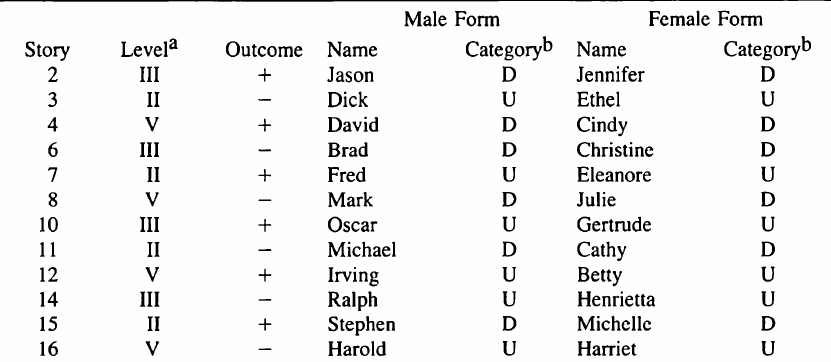
Table 1 Causal Structure, Level, Outcome Quality, and Desirable